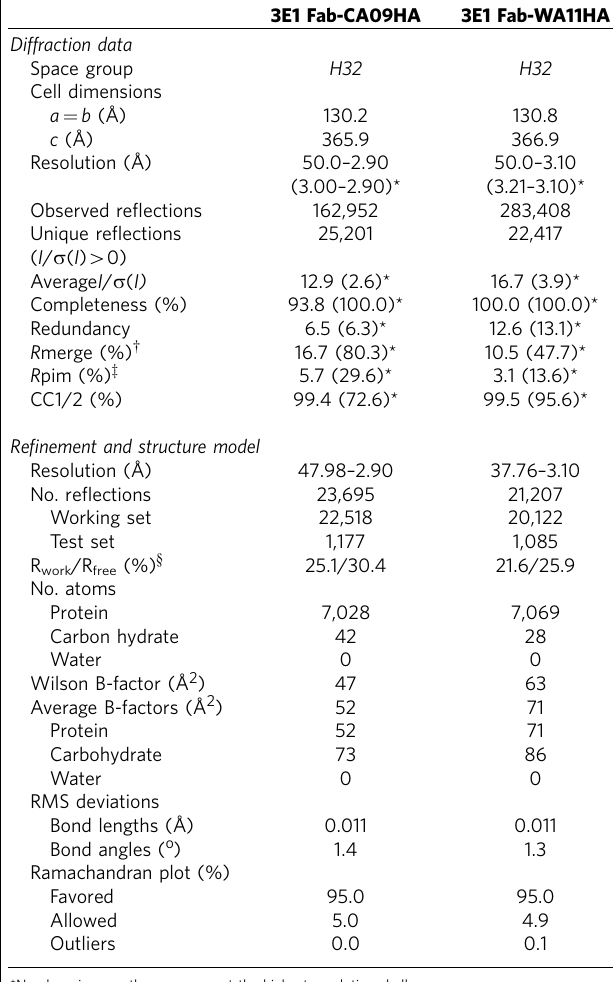
Table 1 | Statistics of X-ray diffraction data and structure